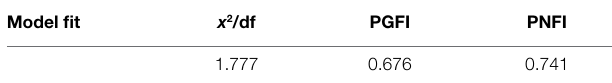
TABLE 6 | Model parsimonious fit